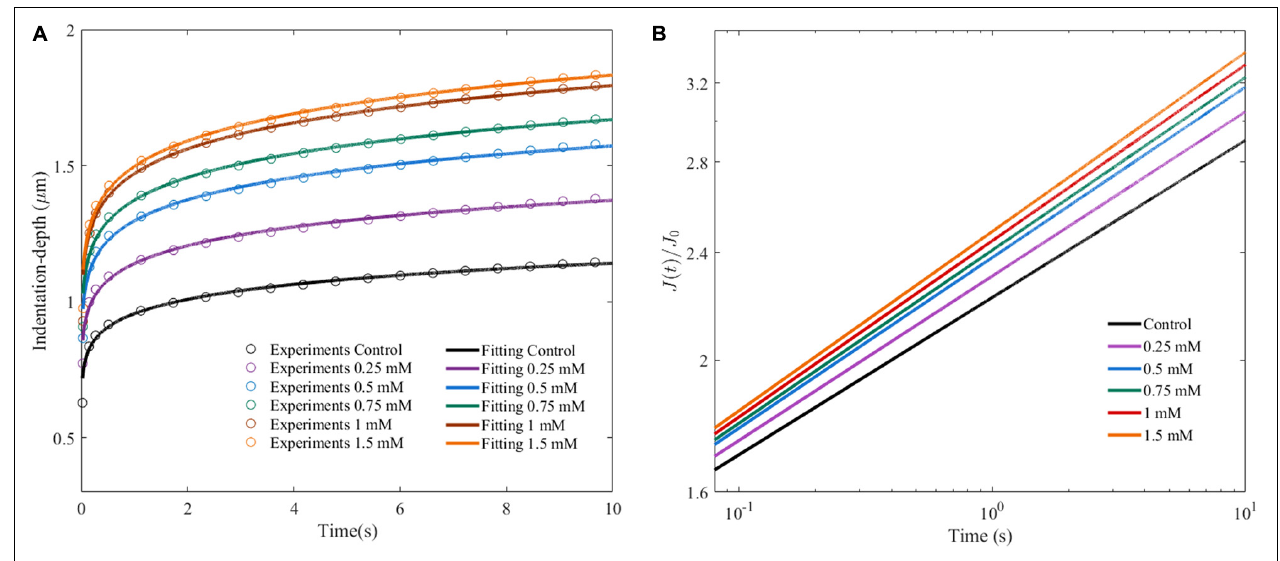
FIGURE 5 | Cell viscoelastic feedback under different concentrations of OA in AFM creep measurements for 24 h. (A) Changes of indentation depth as functions of time after treatment of HepG2 cells with different concentrations of OA. The circle marks represent the average of at least 60 indentation tests. Three independent experiments were performed. (B) Creep compliance response of HepG2 cells after dimensionless.